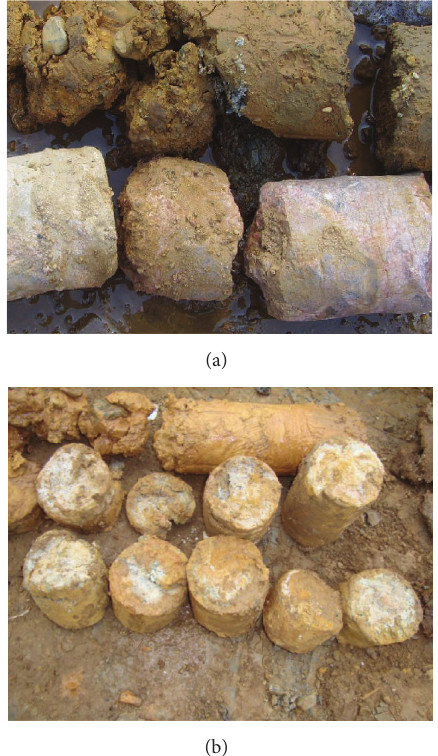
Figure 16: Core sample of sandy gravel after injection.